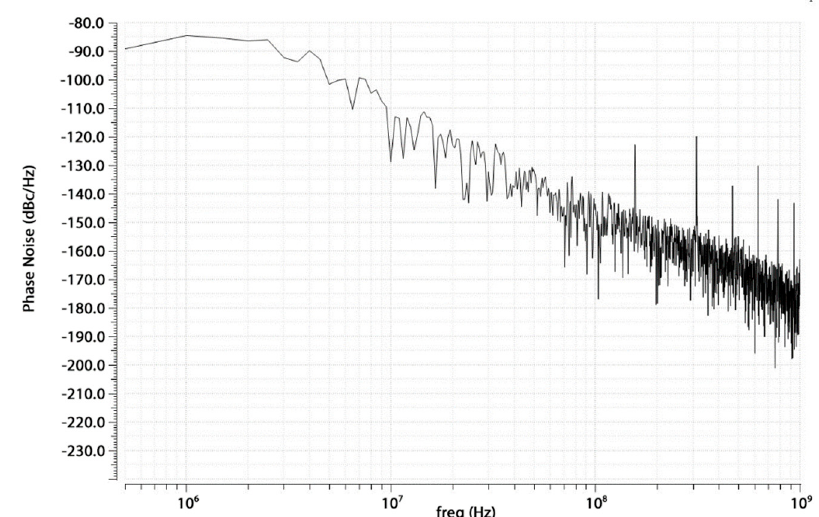
Figure 21. Post-layout phase noise.